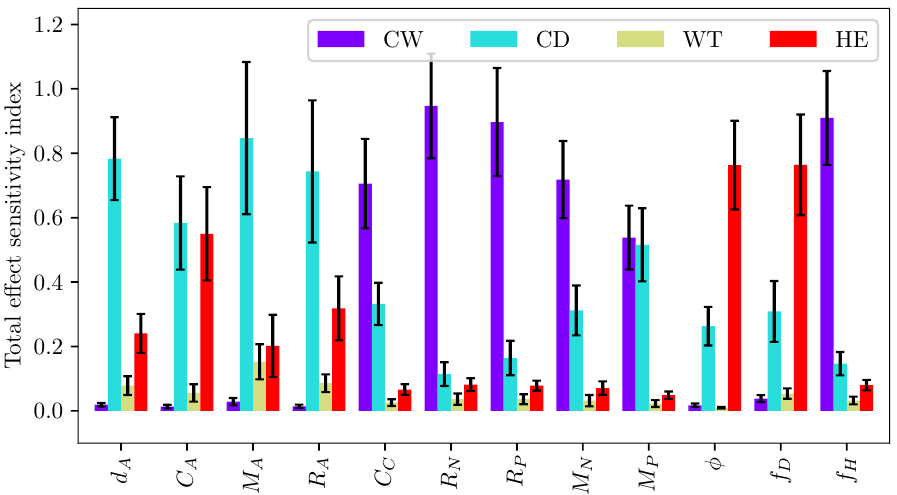
Figure 20. Total sensitivity ( S T ) index of different lumped element parameters with geometrical parameters. The error bar indicates 95% confidence